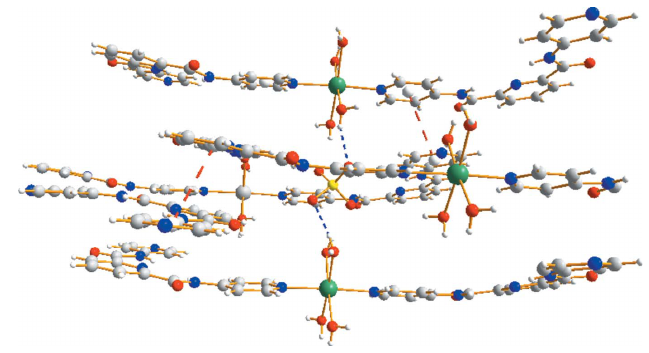
Figure 3 The weak interactions between molecules of complex (I). (cid:2) – (cid:2) inter- actions are shown as red dashed lines, hydrogen-bonding interactions as blue dashed lines.